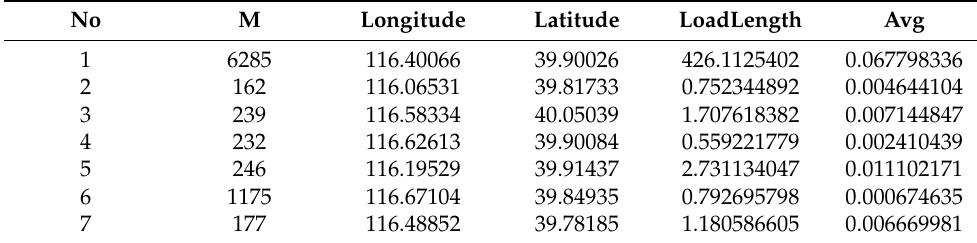
Table 19. The clustering results of PS_DBSCAN for the DS1